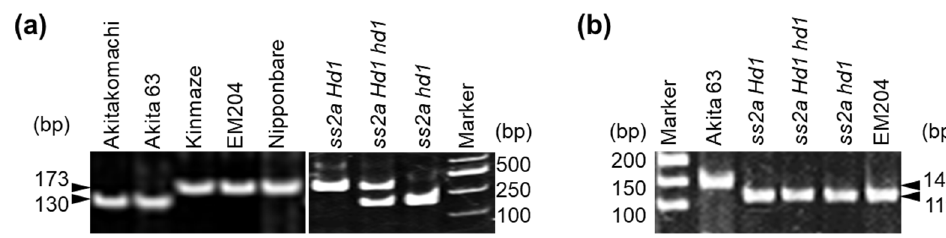
Figure 3. PCR-based screening of rice accessions with variable Hd1 and SSIIa genotypes. ( a ) Screening of Hd1 alleles using #5 and #12 PCR primers listed in Table S1. Lines with the hd1 allele generated 130 bp PCR products, while those with the Hd1 allele generated 173 bp PCR products; the heterozygous ( Hd1 hd1 ) line produced both PCR products. ( b ) Screening of the ss2a allele. Lines carrying the ss2a allele showed 111 bp fragment after digesting with Bgl II, whereas Akita 63 (harboring the ss2a L allele) showed a 141 bp band (undigested by Bgl II).